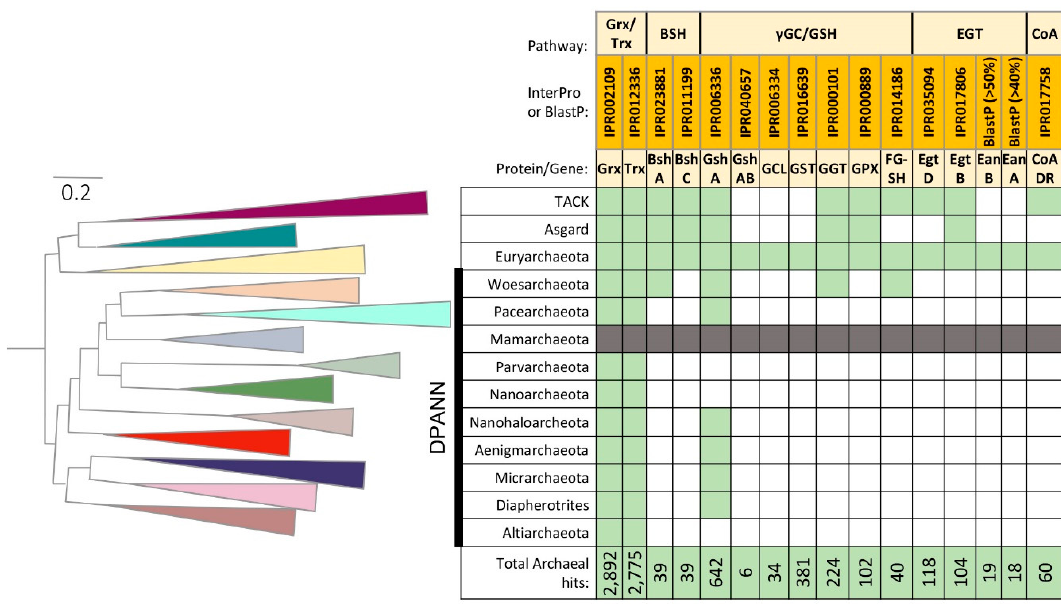
Figure 2. Archaeal protein homologs associated with thiol chemistry and their phylogenetic distribution. Left: Phylogenetic relationship of archaea based on Castelle et al. [39]. Phyla that cluster to DPANN indicated by black vertical bar. Right: Classification of archaeal homologs based on InterPro families and BlastP (See Supplemental Table S1 for details). Green boxes, archaeal groups with homologs. Grey boxes, Mamarchaeota genome unavailable for analysis.